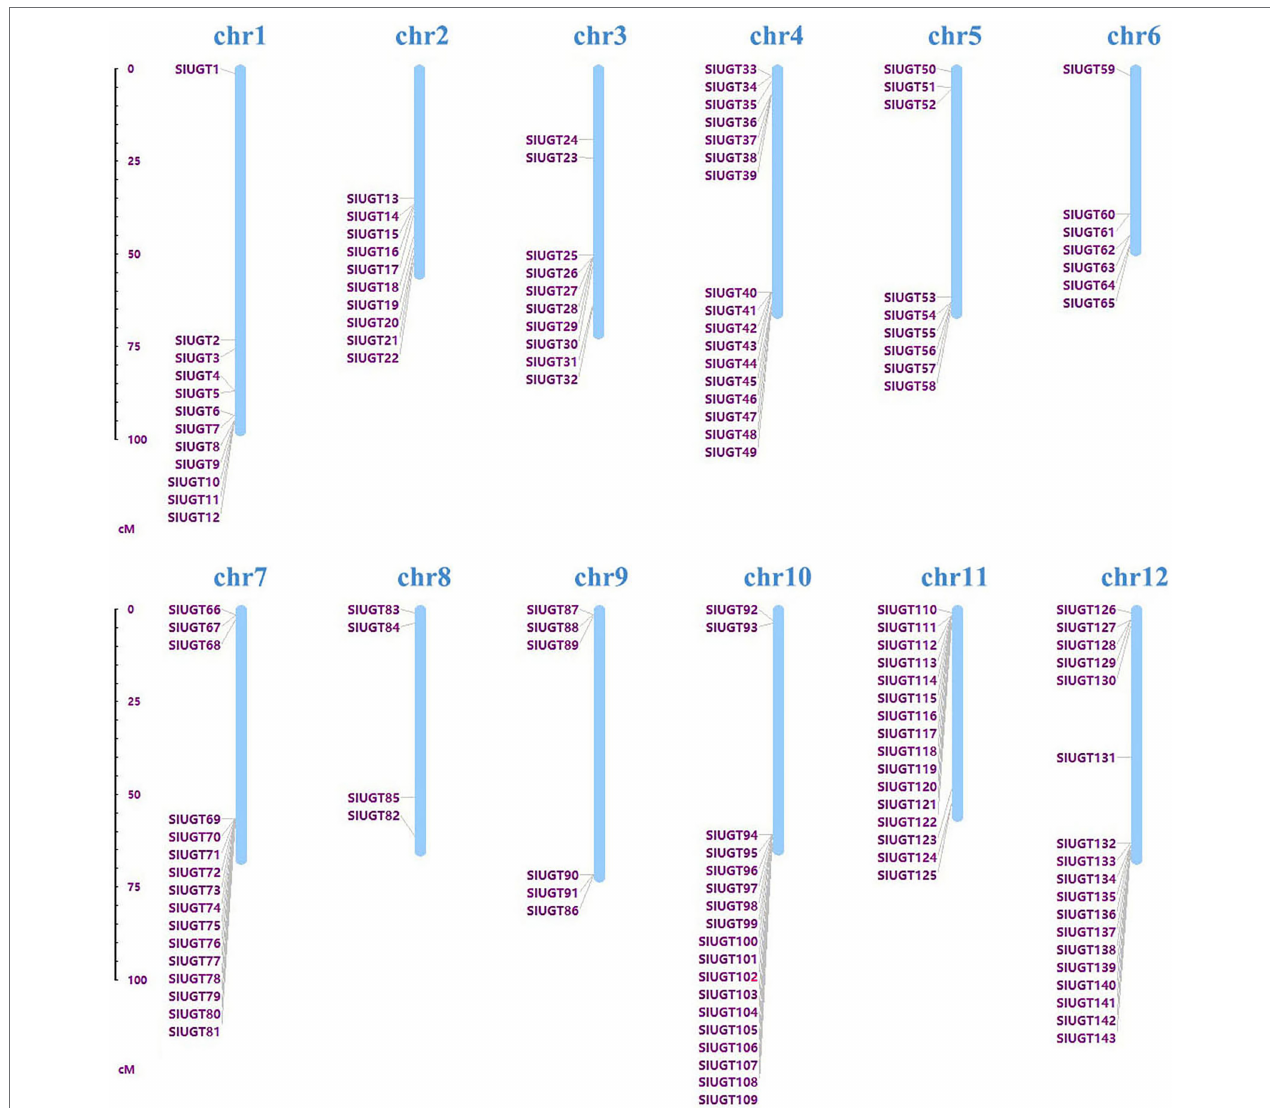
FIGURE 4 | Chromosomal distribution of the 143 SlUGT genes identified in the present study. The chromosome number is indicated above each